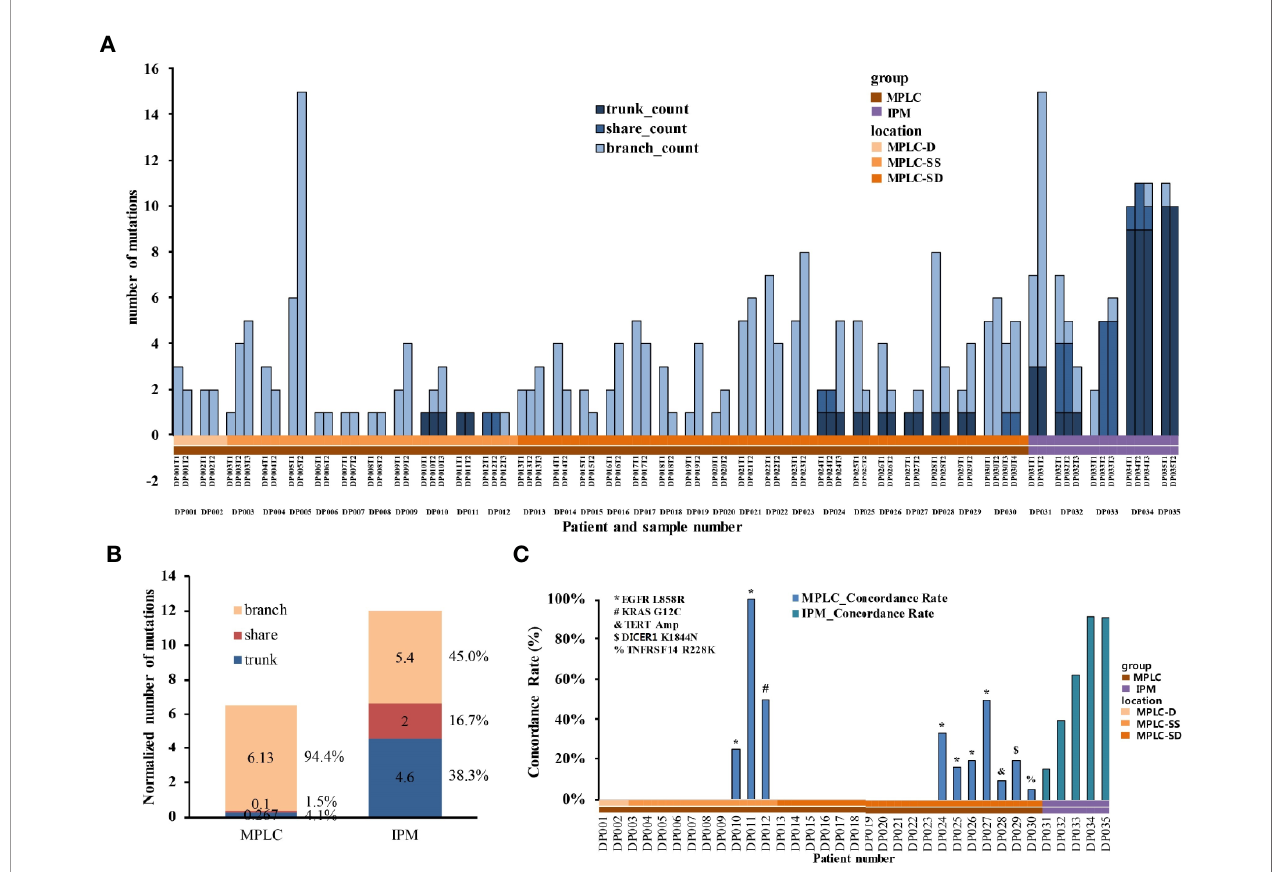
FIGURE 2 | Mutation status and concordance rate for lesions of the training cohort. Panel (A) The number of mutations for all lesions of all patients with MPLC or IPM. Trunk, shared, and branch mutations are shown as indicated. Panel (B) Comparison of the normalized number of mutations (total number of mutations/number of patients) for MPLC and IPM. The ratio of trunk, shared, and branch mutations are shown as indicated. Panel (C) The concordance rate for each patient, with key common driver genes labeled. MPLC-SD, lesions at the same lung but different lobes; MPLC-SS, lesions at the same lung and same lobe; MPLC-D, lesions at bilateral